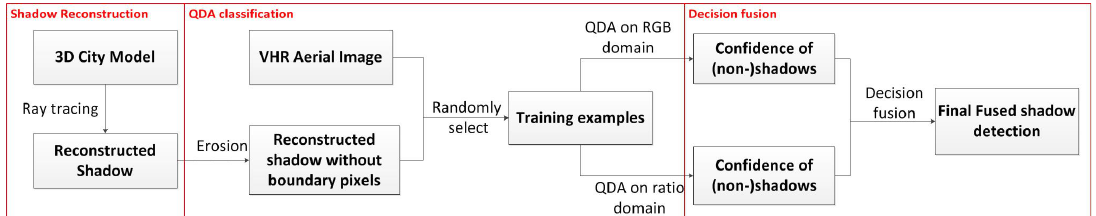
Figure 2. The flow chart of methodology.